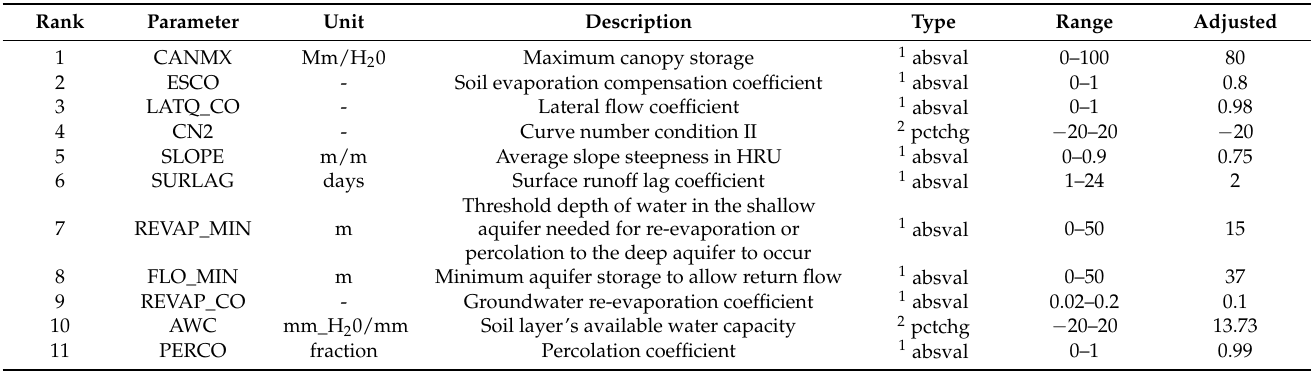
Figure 7. Boxplots of the ( a ) R10 mm, ( b ) R20 mm, ( c ) R50 mm and ( d ) Rx1d values at the evaluated climate stations during the 2025–2044, 2045–2064 and 2065–2084 periods. Table 2. SWAT+ calibration parameter sensitivity, description, range and adjusted